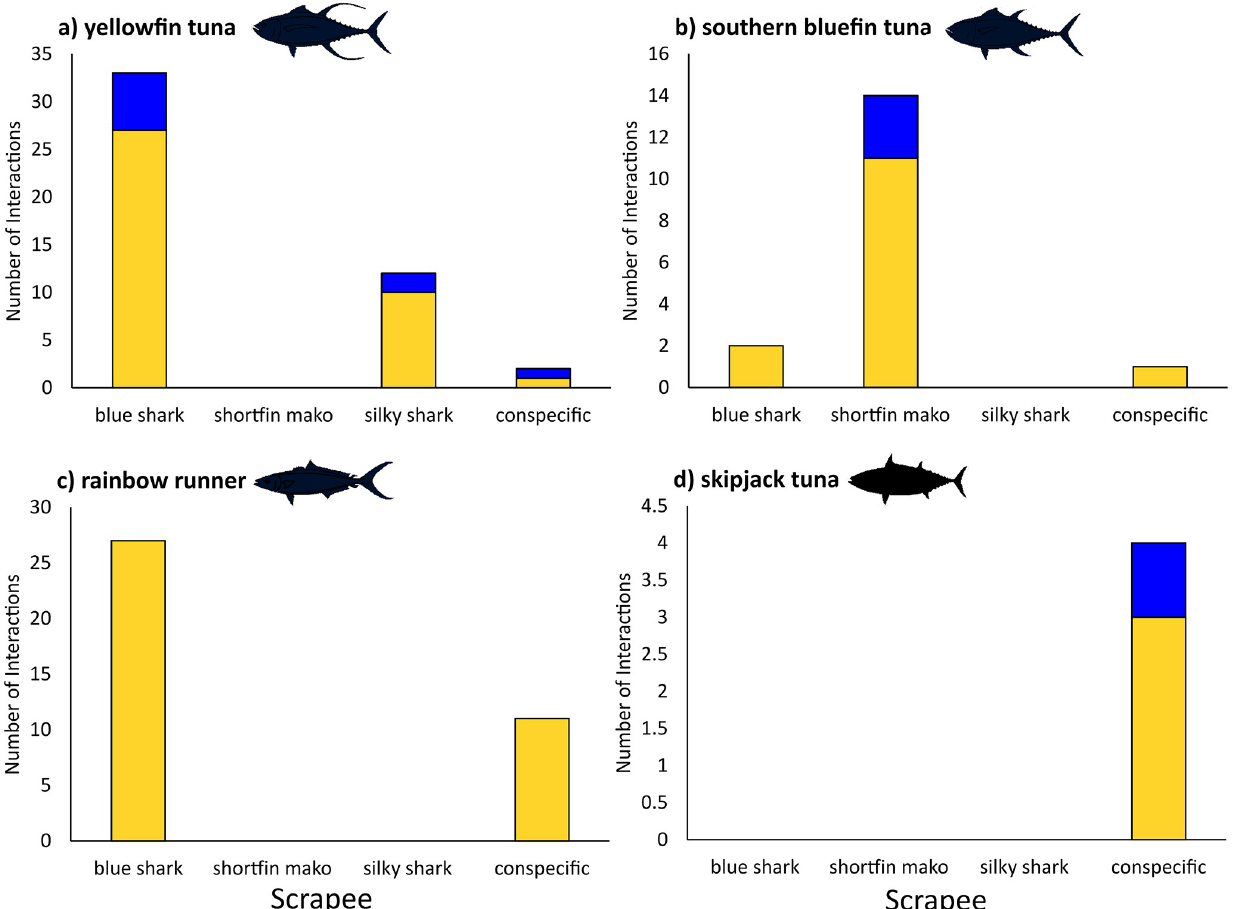
Fig 2. Number of successful (yellow) and unsuccessful (blue) scraping interactions by scrapers on scrapees across all sample sites for a) yellowfin tuna Thunnus albacares , b) southern bluefin tuna Thunnus maccoyii , c) rainbow runner Elegatis bipinnulata , and d) skipjack tuna Katsuwonus pelamis